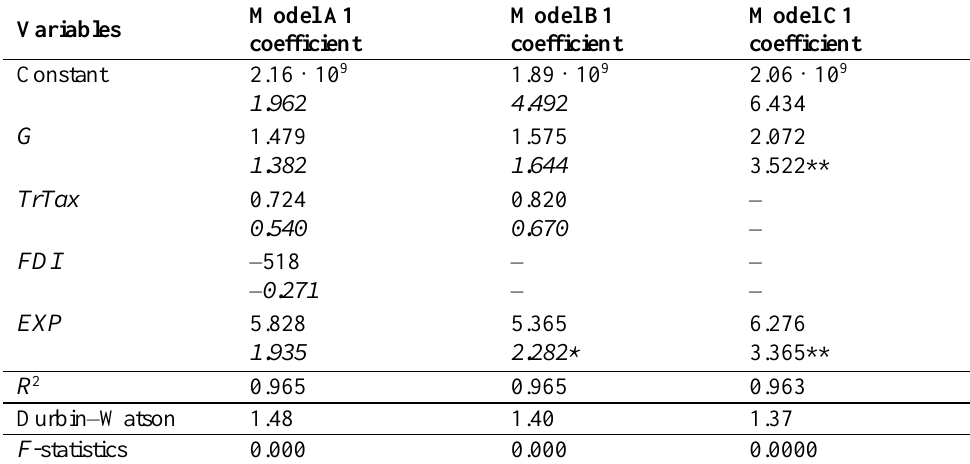
Table 3. Regression Coefficients of the Best Fitted First